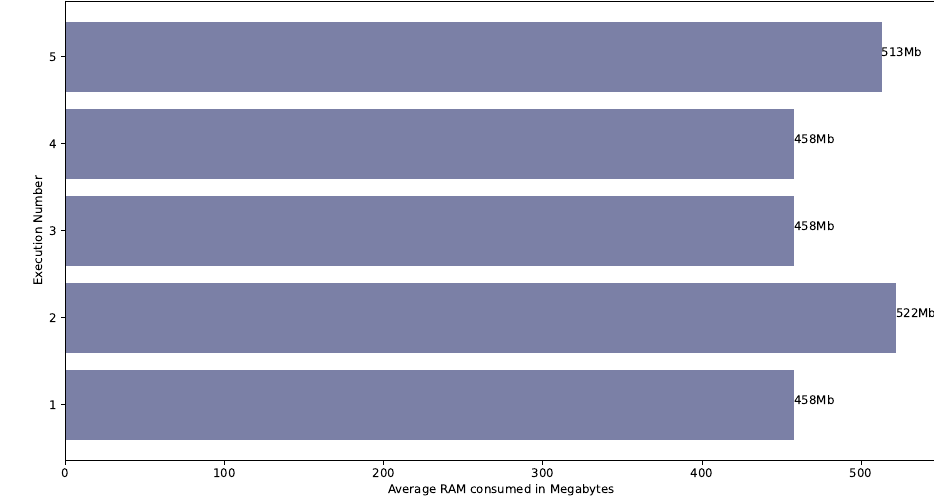
Figure 15. CPU usage by Pangea over different